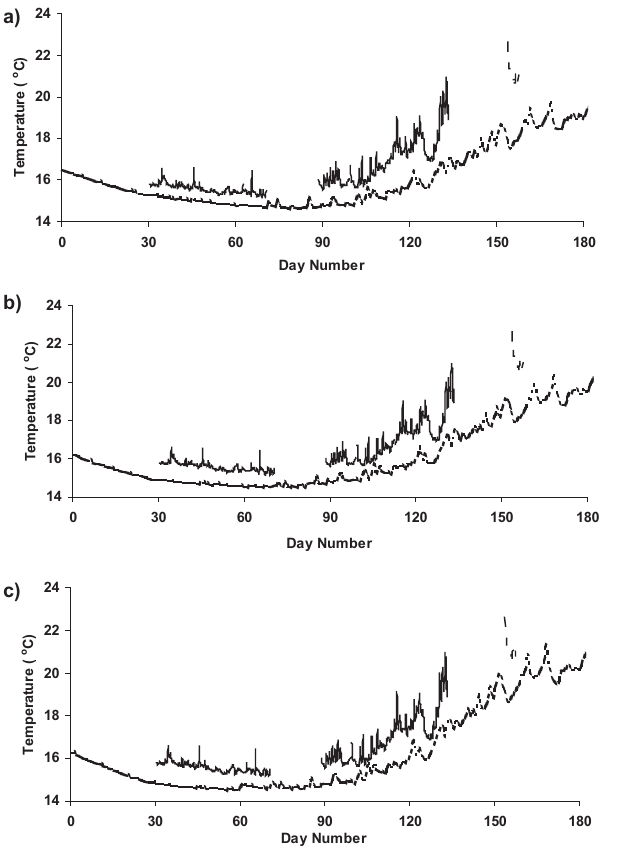
Fig. 3. Surface temperature for (a) PA1, (b) PA2 and (c) PA3 runs. Dashed line indicates model, solid line indicates data.